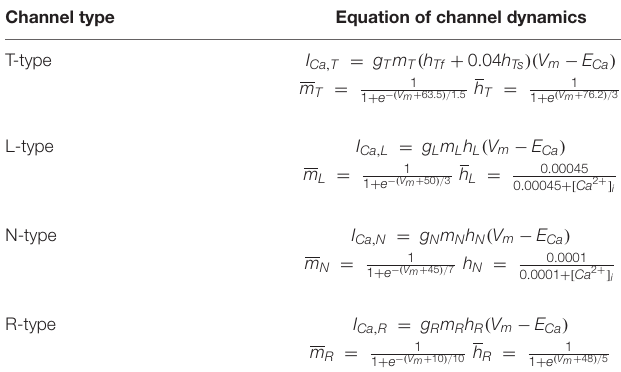
TABLE 1 | Details of the voltage-gated calcium